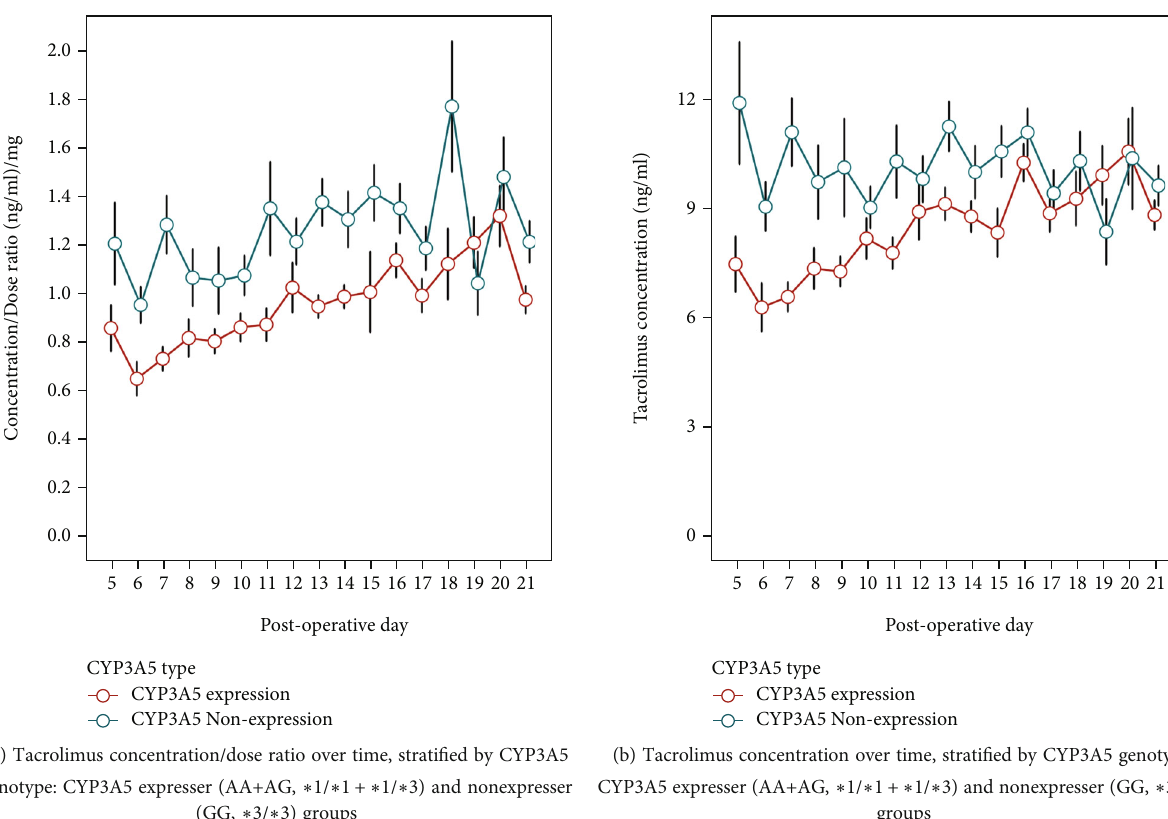
Figure 2: E ff ect of the CYP3A5 genotype on tacrolimus PK